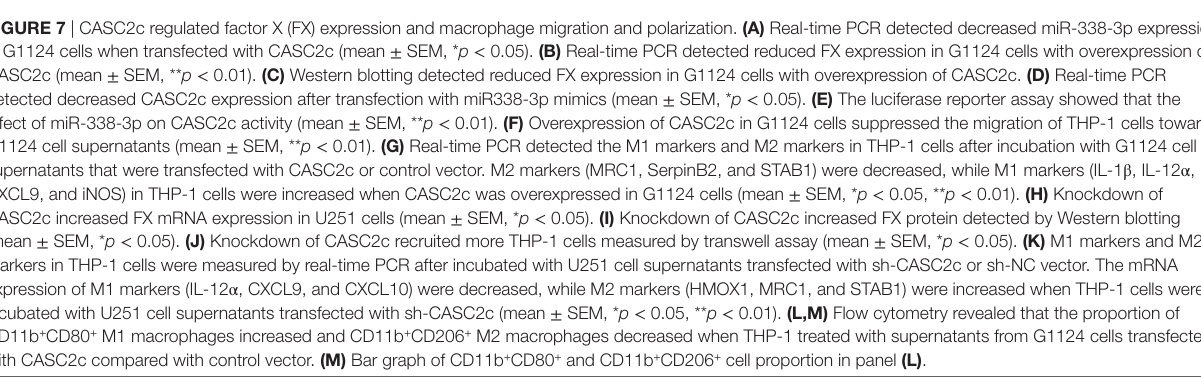
FigUre 7 | CASC2c regulated factor X (FX) expression and macrophage migration and polarization. (a) Real-time PCR detected decreased miR-338-3p expression in G1124 cells when transfected with CASC2c (mean ± SEM, * p < 0.05). (B) Real-time PCR detected reduced FX expression in G1124 cells with overexpression of CASC2c (mean ± SEM, ** p < 0.01). (c) Western blotting detected reduced FX expression in G1124 cells with overexpression of CASC2c. (D) Real-time PCR detected decreased CASC2c expression after transfection with miR338-3p mimics (mean ± SEM, * p < 0.05). (e) The luciferase reporter assay showed that the effect of miR-338-3p on CASC2c activity (mean ± SEM, ** p < 0.01). (F) Overexpression of CASC2c in G1124 cells suppressed the migration of THP-1 cells toward G1124 cell supernatants (mean ± SEM, ** p < 0.01). (g) Real-time PCR detected the M1 markers and M2 markers in THP-1 cells after incubation with G1124 cell supernatants that were transfected with CASC2c or control vector. M2 markers (MRC1, SerpinB2, and STAB1) were decreased, while M1 markers (IL-1 β , IL-12 α , CXCL9, and iNOS) in THP-1 cells were increased when CASC2c was overexpressed in G1124 cells (mean ± SEM, * p < 0.05, ** p < 0.01). (h) Knockdown of CASC2c increased FX mRNA expression in U251 cells (mean ± SEM, * p < 0.05). (i) Knockdown of CASC2c increased FX protein detected by Western blotting (mean ± SEM, * p < 0.05). (J) Knockdown of CASC2c recruited more THP-1 cells measured by transwell assay (mean ± SEM, * p < 0.05). (K) M1 markers and M2 markers in THP-1 cells were measured by real-time PCR after incubated with U251 cell supernatants transfected with sh-CASC2c or sh-NC vector. The mRNA expression of M1 markers (IL-12 α , CXCL9, and CXCL10) were decreased, while M2 markers (HMOX1, MRC1, and STAB1) were increased when THP-1 cells were incubated with U251 cell supernatants transfected with sh-CASC2c (mean ± SEM, * p < 0.05, ** p < 0.01). (l,M) Flow cytometry revealed that the proportion